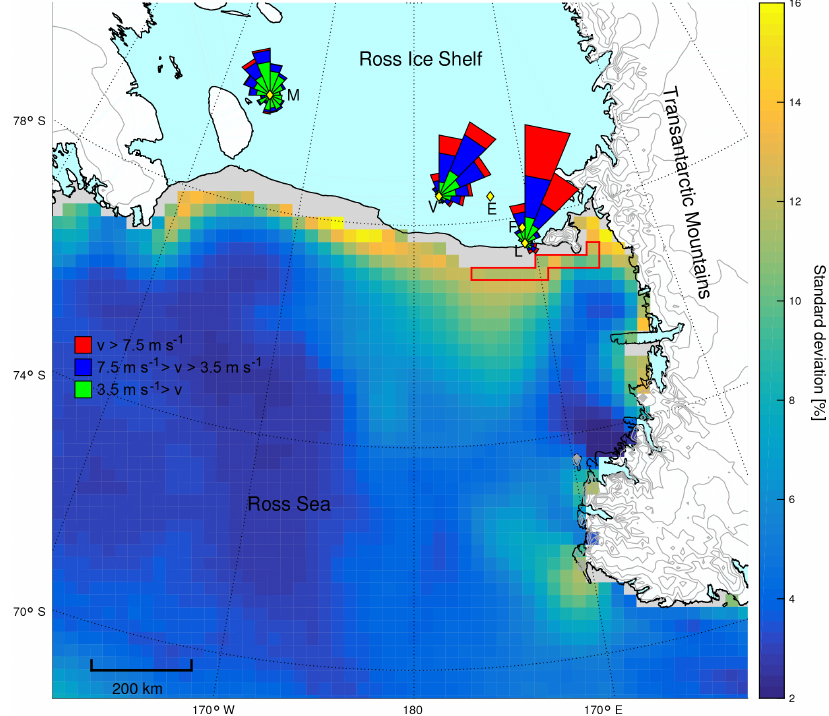
Figure 1. Map of Ross Sea region, grey contour lines indicate topography at 500m intervals (Liu et al., 2001). The color scale indicates the standard deviation of bootstrap SIC for 20 April–1 November 1979–2014. Yellow diamonds indicate the positions of Margaret, Vito, Emilia, Ferrell and Laurie II AWS sites, labeled M, V, E, F and L, respectively. Wind roses for Margaret, Vito and Laurie II are included. The green, blue and red colors indicate the low, medium and high wind speeds based on the 33rd and 66th percentile wind speeds (3 . 5 and 7 . 5ms − 1 ) as measured at Laurie II. The red line outline indicates the region discussed in Sect.